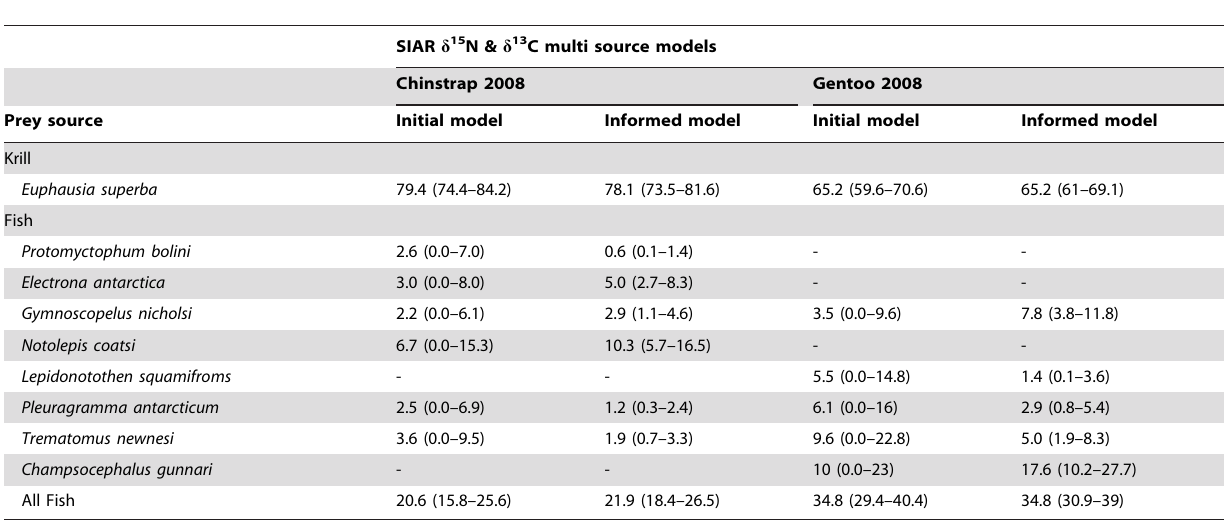
Table 4. Predicted diet compositions of penguin chicks at Cape Shirreff, Livingston Island derived from stable isotope analysis using two variants of a multi-source Bayesian mixing